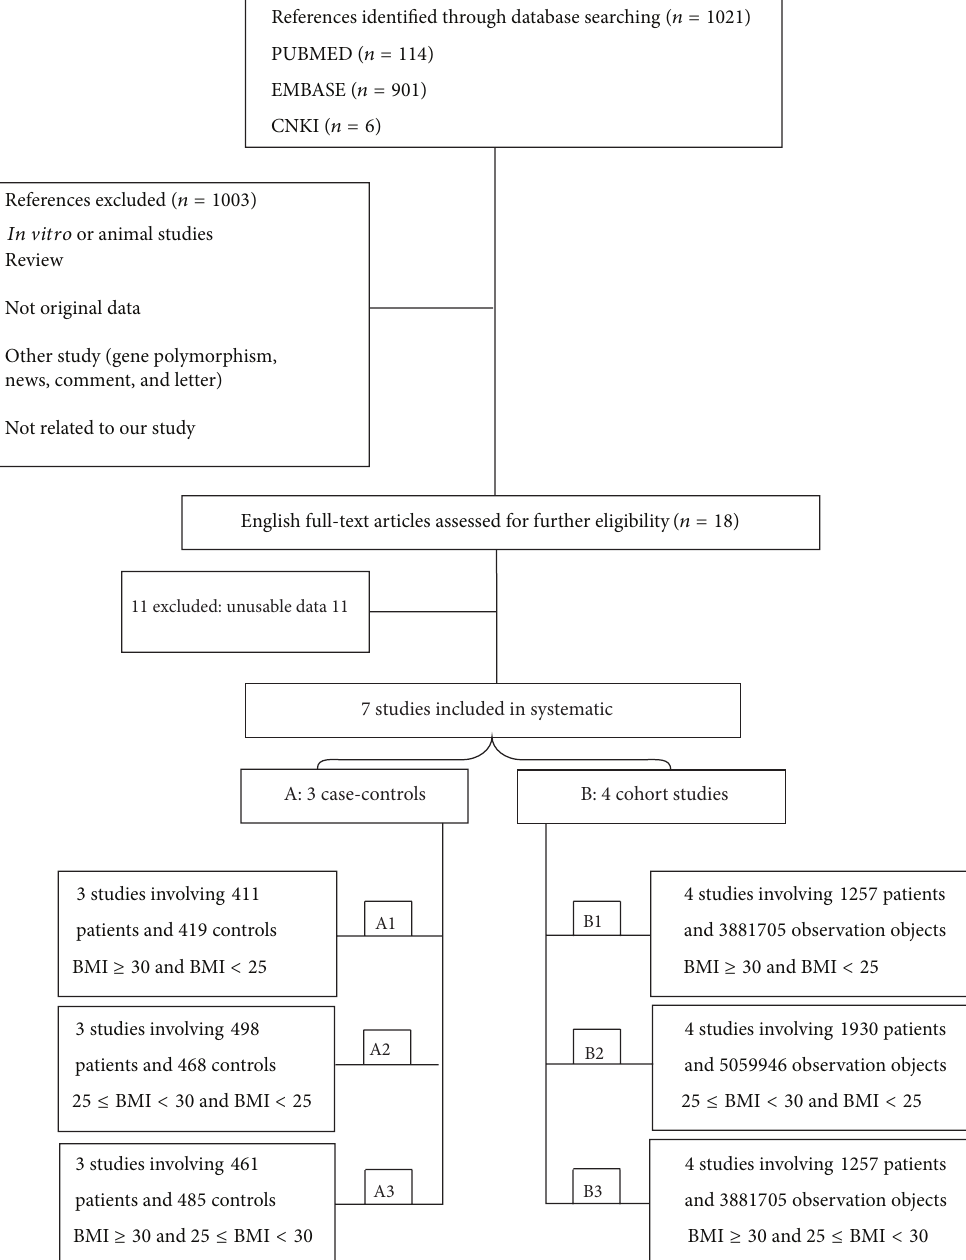
Figure 1: Flow diagram of the